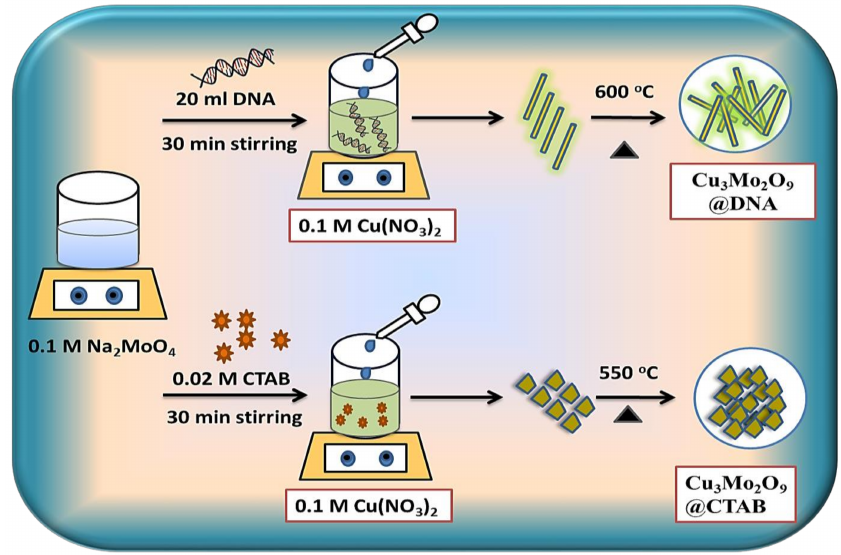
Figure 1. Schematic of Cu 3 Mo 2 O 9 @DNA and Cu 3 Mo 2 O 9 @CTAB synthesis by coprecipitation fol- lowed by annealing